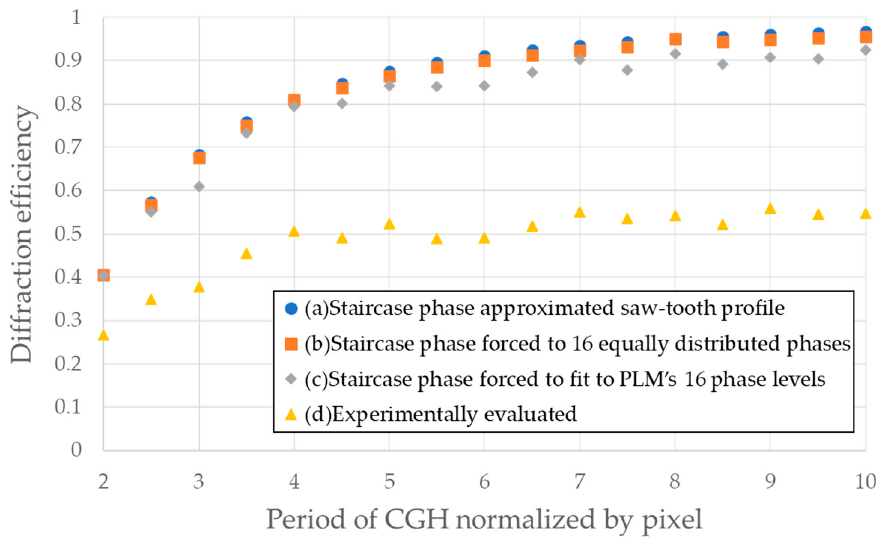
Figure 3. Diffraction efficiency of CGH for ( a ) staircase phase-approximated sawtooth profile, ( b ) staircase phase approximated and forced to fit 16 equally distributed phases across 0 to 2 π , ( c ) staircase phase forced to fit TI-PLM’s available 16 phase levels (Figure 2a). and ( d ) experimentally evaluated.